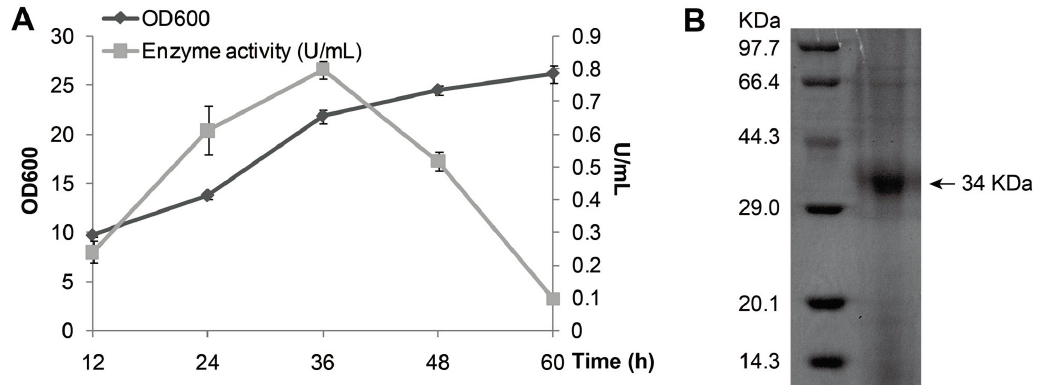
Figure 2. Expression and purification of MAJ1. ( A ) Growth curve of P. pastoris X-33 with MAJ1; and ( B ) Purification of MAJ1. The enzyme activity refers to the activity of the supernatant of fermentation